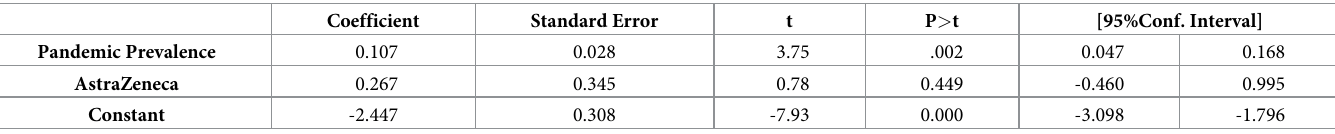
Table 5. Results of meta-regression including AstraZeneca as a dummy variable.